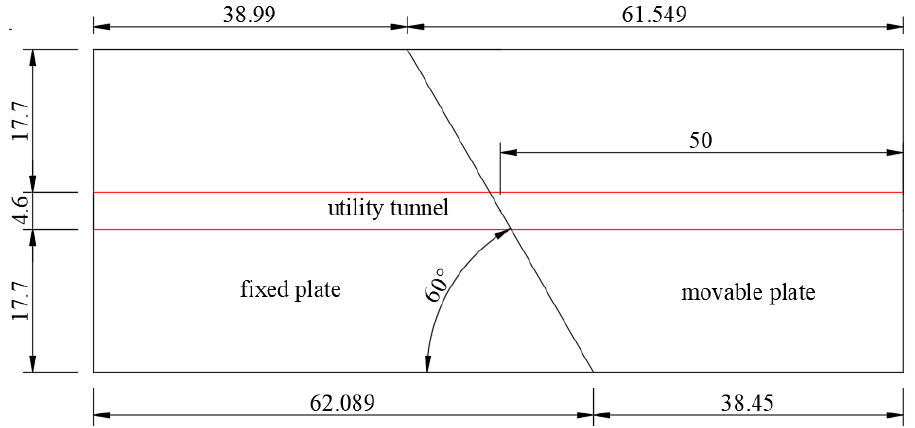
Figure 15. Distribution curve of the longitudinal horizontal opening displacement. ( a ) Roof ( b ) Floor.